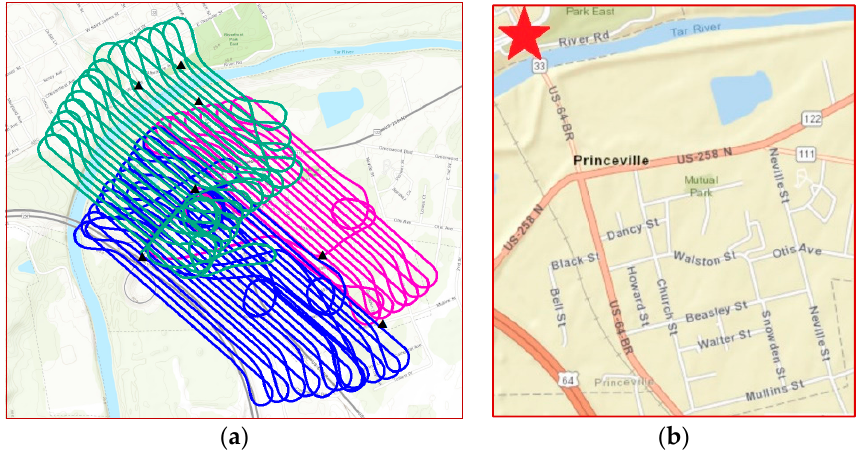
Figure 2. ( a ) Three flight blocks and distribution of the seven (7) ground control points (GCPs) in the study area, ( b ) Location of the 33661 USGS Gauge Station 02083500 TAR RIVER is shown by a red star (TARBORO vicinity map).